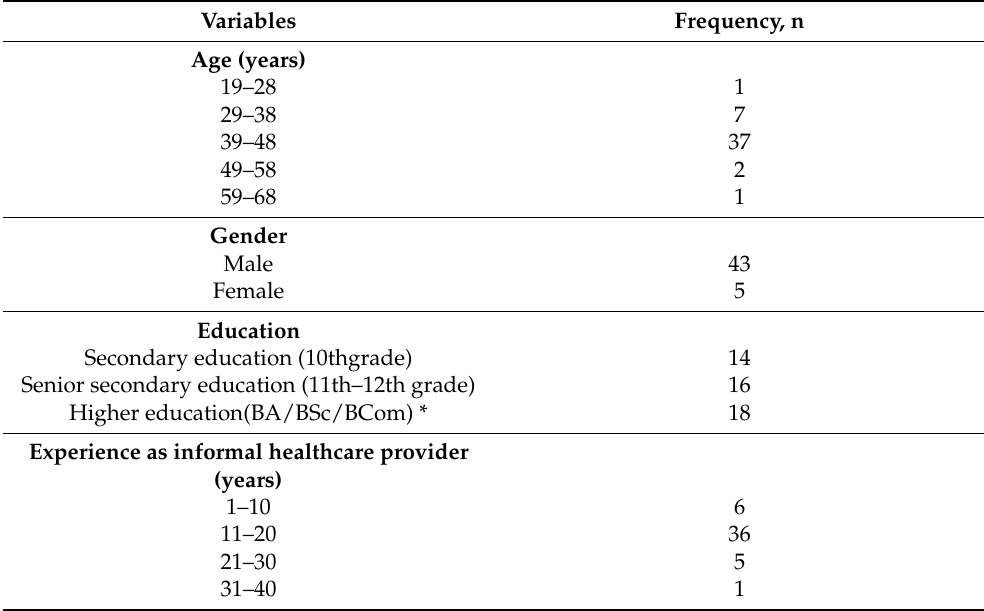
Table 1. Informal healthcare provider’s demographic characteristics ( n =